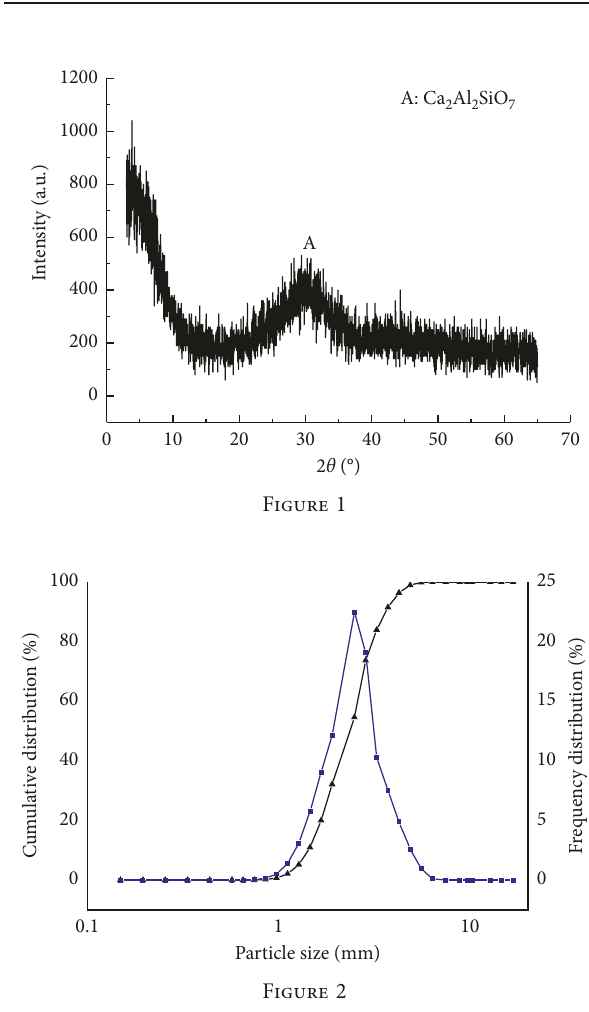
Table 2: Levels and factors of the orthogonal test. Levels